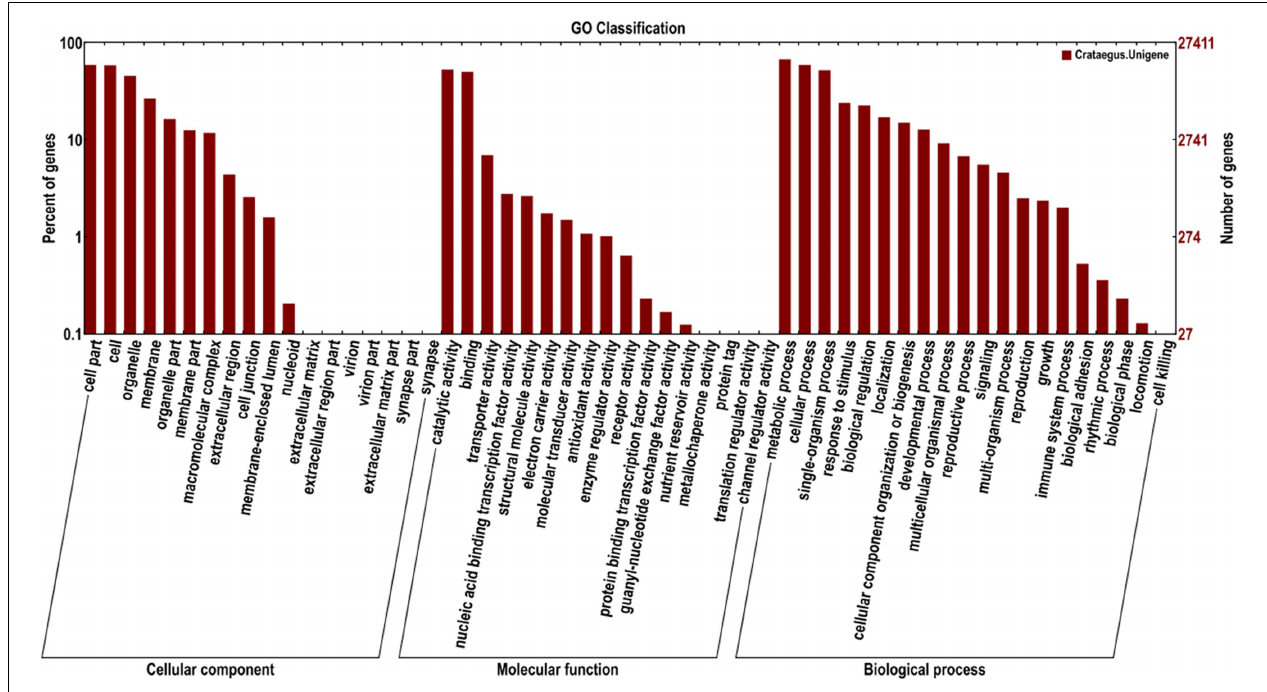
FIGURE 3 | Histogram of the GO classifications of the assembled C. pinnatifida unigenes. Most consensus sequences were grouped into three major functional categories, namely, biological processes, cellular components, and molecular functions.